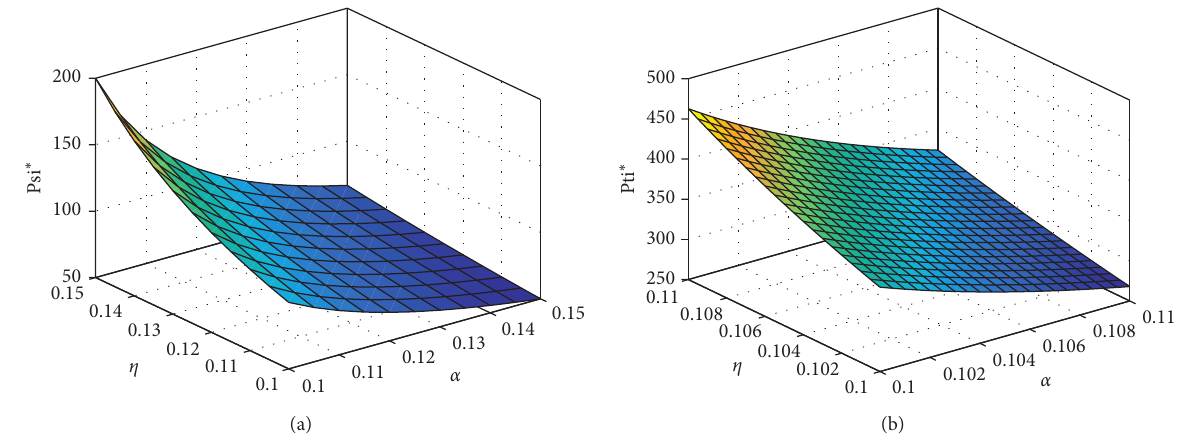
Figure 5: Price strategies in the simultaneous decision situation. (a) p ∗